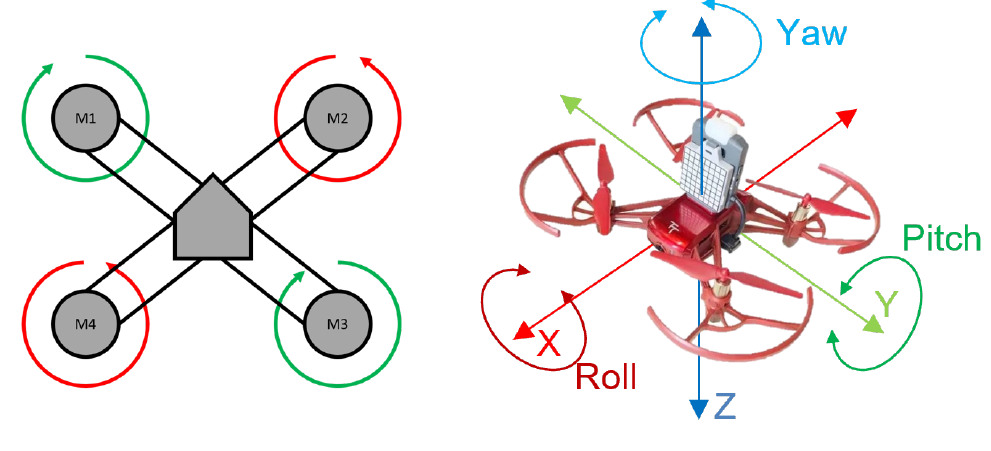
Figure 1. ( Left ): A quadrocopter with the directions of the turning propellers displayed. ( Right ): The six DOFs of our drone.